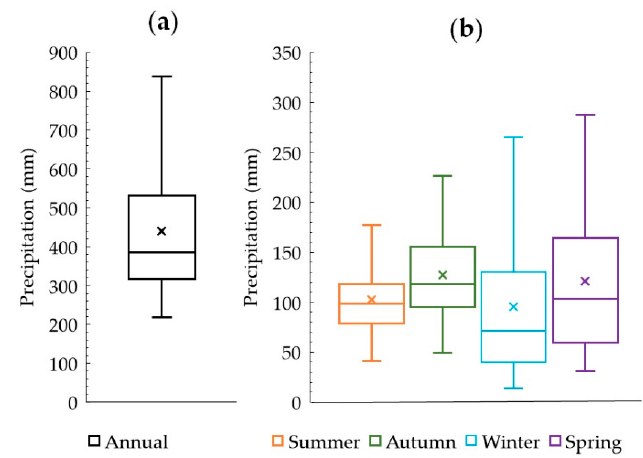
Figure 5. ( a ) Box plots of the annual precipitation and ( b ) seasonal total precipitation accumulation